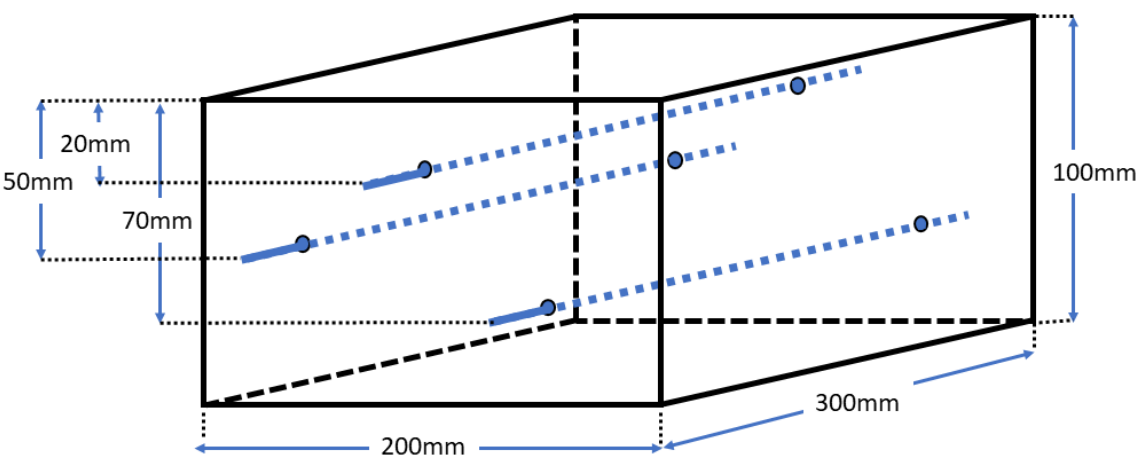
Figure 1. Schematic of mortar sample showing position of bars (not to scale).